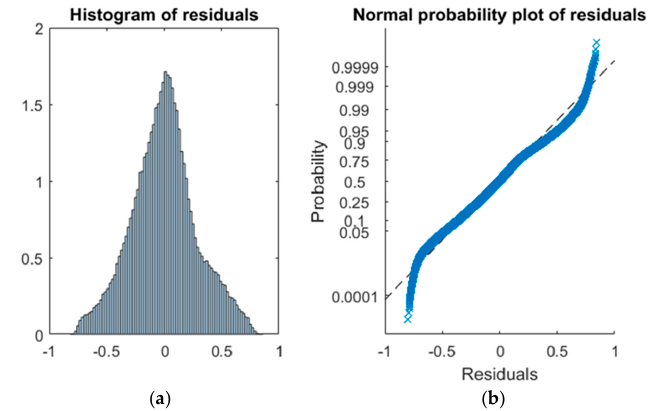
Figure 8. Plot of residuals for the linear model after the removal of outliers. ( a ) Histogram. ( b ) Normal Probability.